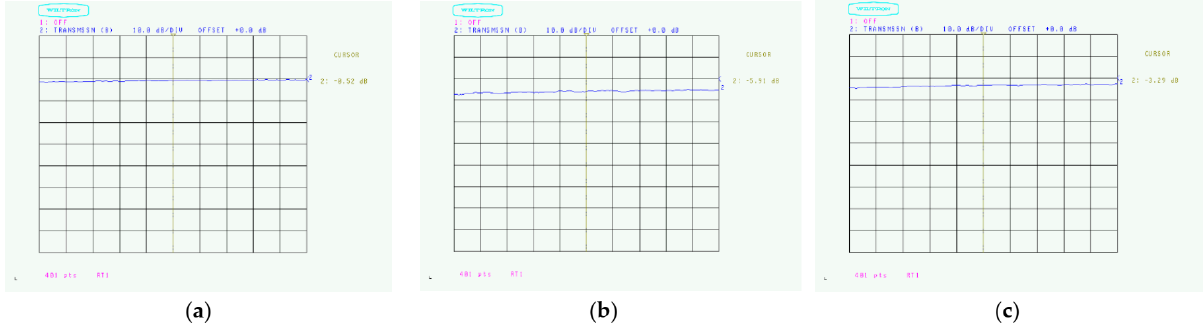
Figure 12. Radio wave absorption of CNT spray paint: ( a ) Coating thickness 16 µ m (0.52 dB); ( b ) Coating thickness 35 µ m (5.91 dB); ( c ) Coating thickness 76 µ m (3.29 dB).